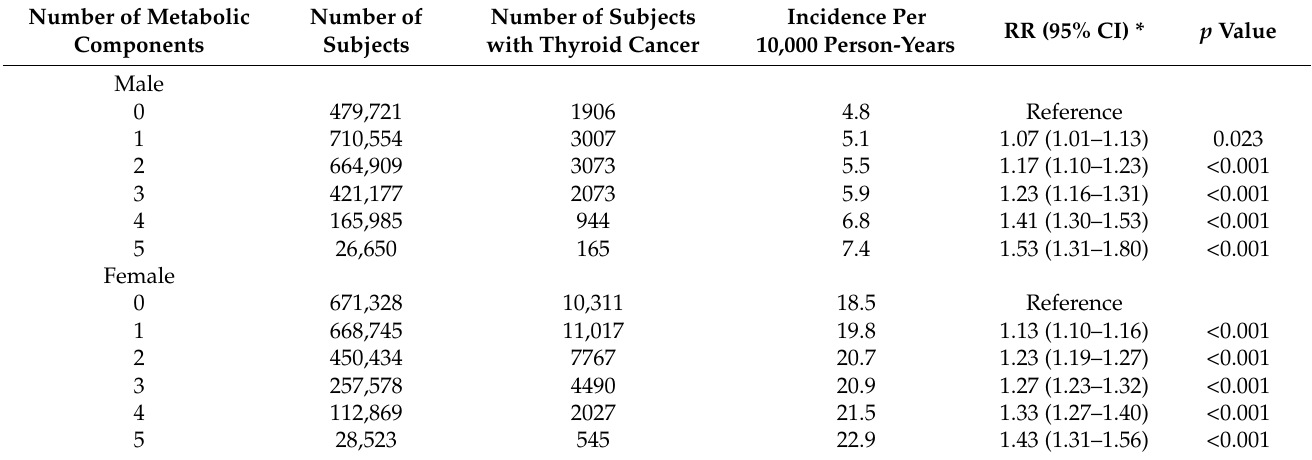
Table 4. Association of the number of metabolic syndrome components with the risk of thyroid